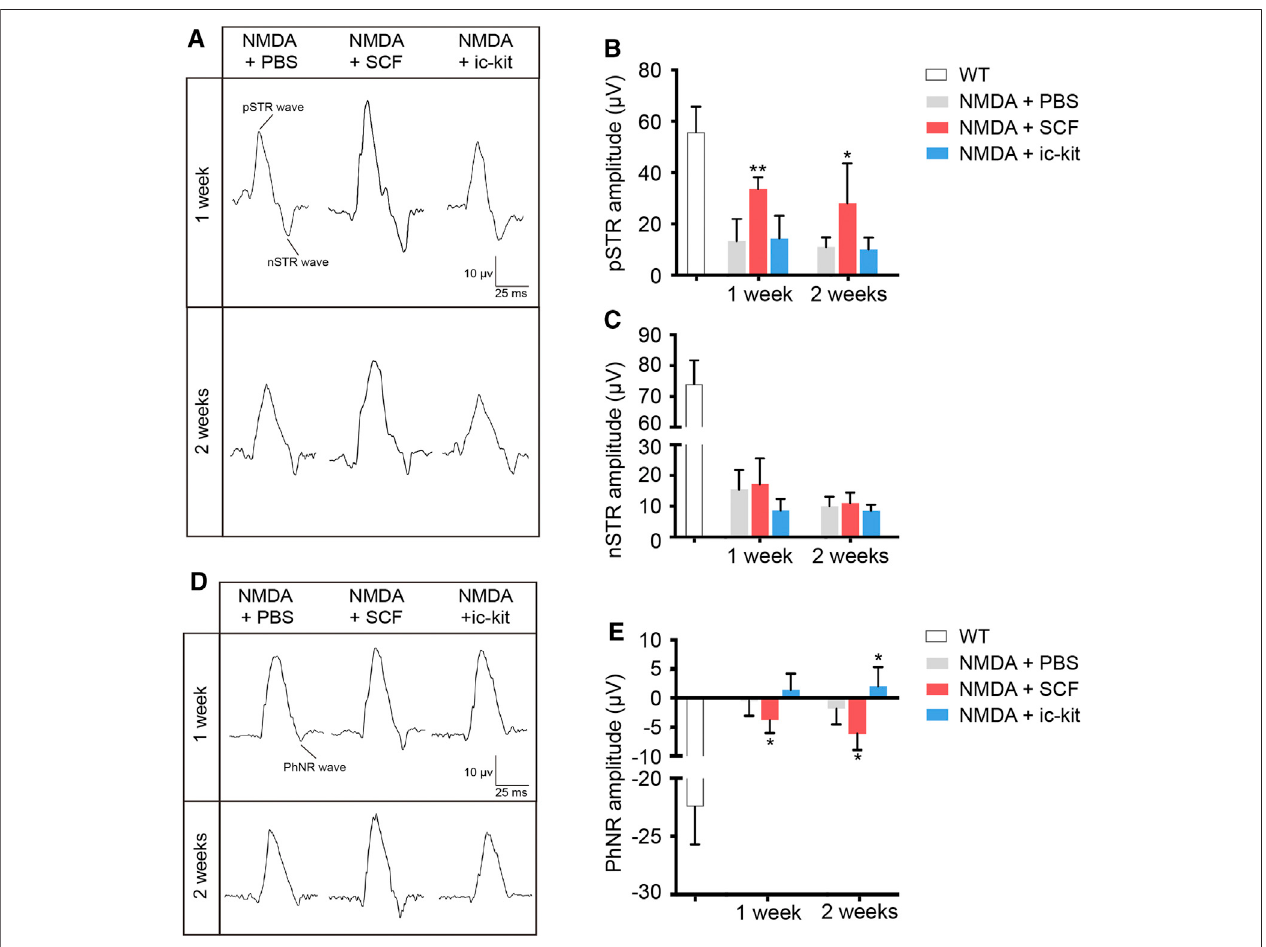
FIGURE6| SCFTreatmentMaintainedtheFunctionofRGCsinNMDA-treatedMice. (A) SpecializedfERGtestsfordetectingthefunctionofRGCswereperformed at designed timepoints. Representativewavesofpositivescotopicthreshold responses(pSTR)and negative STR(nSTR)inthesegroups. (B,C) AmplitudesofpSTR (B) and nSTR (C) were compared among groups. (D) Representative waves of photopic negative response (PhNR). (E) Statistical analysis of PhNR amplitudes among groups. Data were shown as mean ± SD ( n = 5 for each time point). * p < 0.05, ** p < 0.01, compared with the control group (NMDA + PBS).